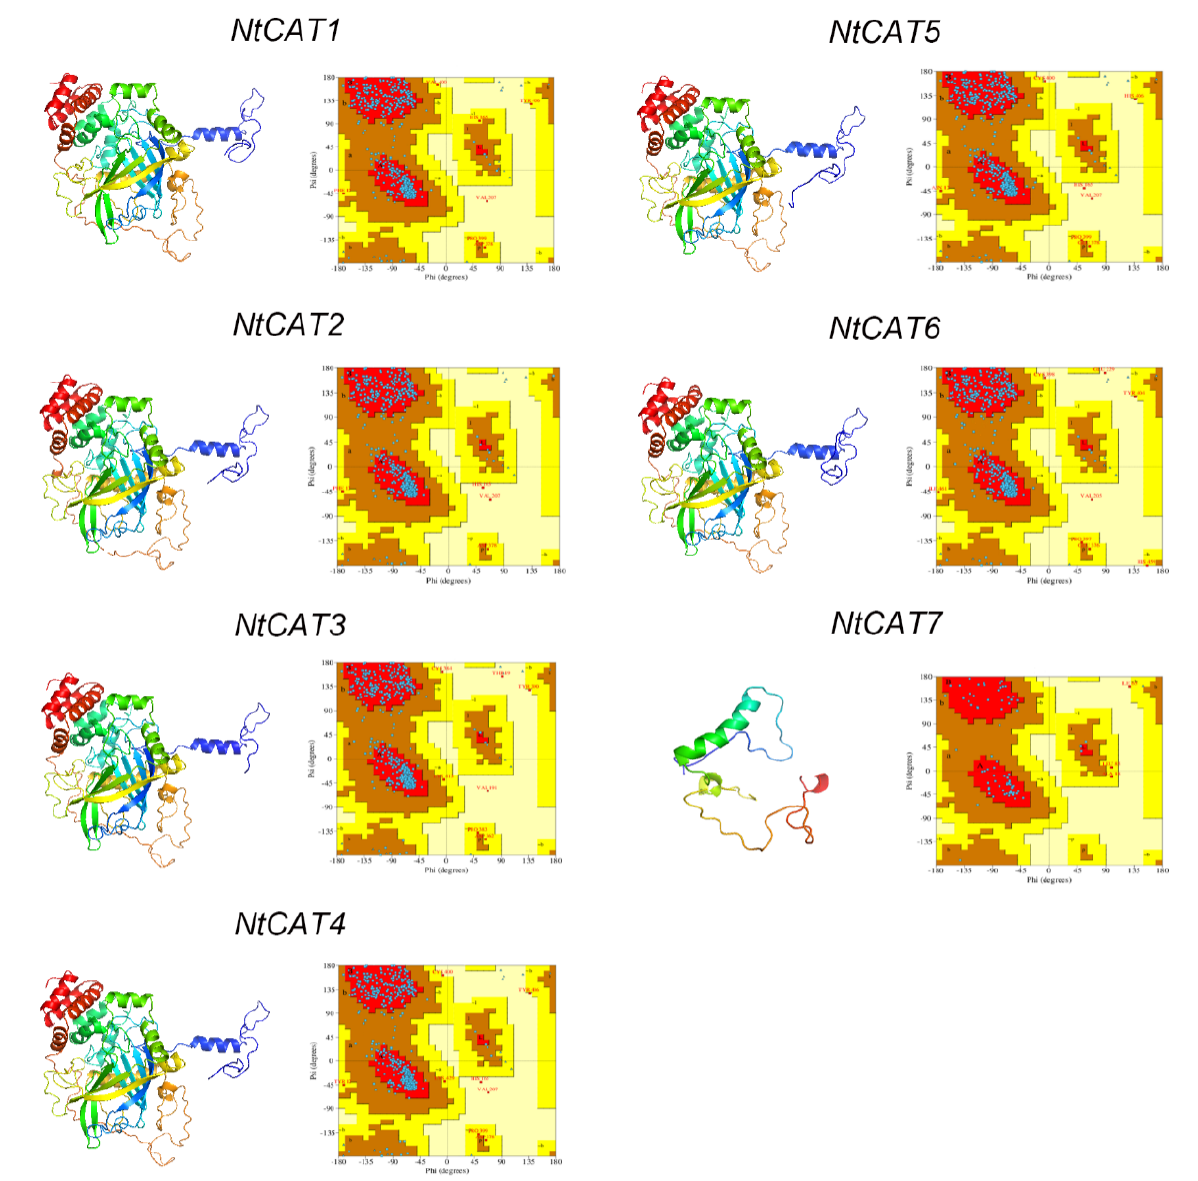
Figure 7. The 3D structures of NtCAT proteins and ramachandran plot analysis. The red, brown and yellow areas represent the preferred, permitted and generally permitted areas, respectively. The lightest areas represent the